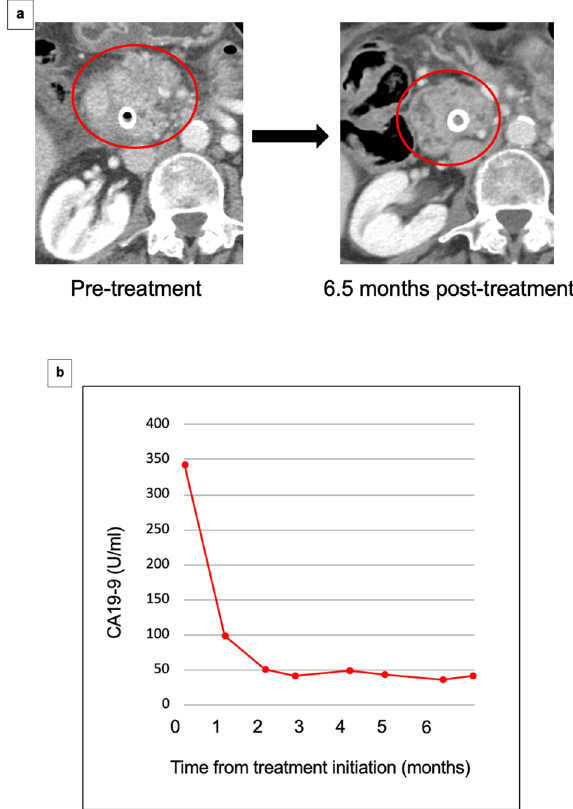
Fig. 4 Illustrative case #18 (see Table 2). Sixty-four-year-old woman with pancreatic cancer with KRAS G12D, KRAS G12R, CDKN2A loss exons 1 – 2, CDKN2B loss, SMAD4 deletion exon 11, TP53 R267W on tissue NGS treated with palbociclib (targets CDK4/6 upregulated by CDKN2A/B loss), trametinib (targets MEK, upregulated by KRAS and SMAD4 mutations), and bevacizumab (targets VEGF, upregulated by TP53 mutations). There were no serious drug-related side effects. She achieved partial response with PFS of 17.5 months. Patient died from complications of a chronic obstructive pulmonary disease exacerbation, which was felt to be unrelated to her cancer or her therapy. At the time of death, patient was free from progression. a Serial CT scans of primary pancreatic mass. b CA-19-9 trend on therapy (reference range, 30 – 42